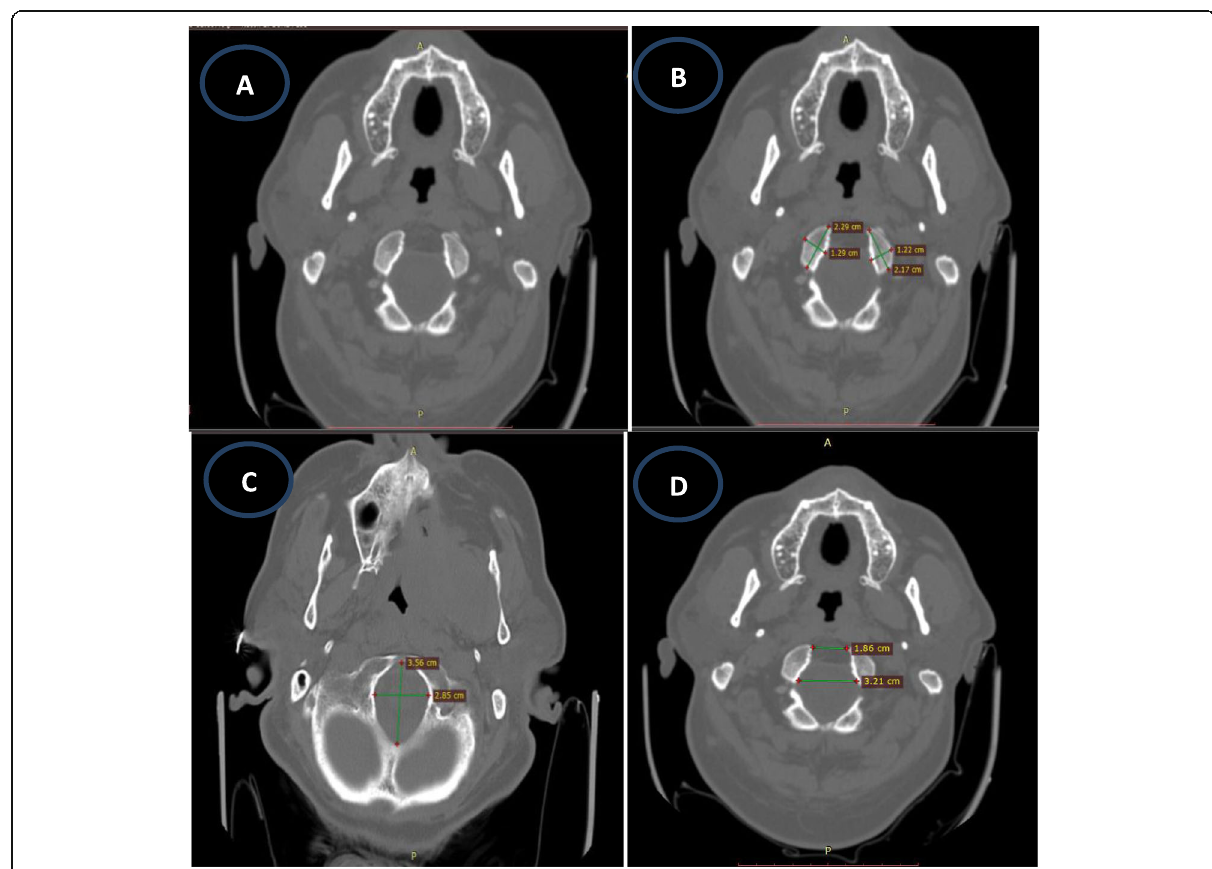
Fig. 1 CT scan images of foramen magnum (FM) showing the studied parameters in axial cross sectional views: ( A ) bony window of the FM and occipital condyles; ( B ) shows the length and width of occipital condyles on both sides; ( C ) shows the length and width of FM; ( D ) shows maximum bicondylar distance and minimum intercondylar